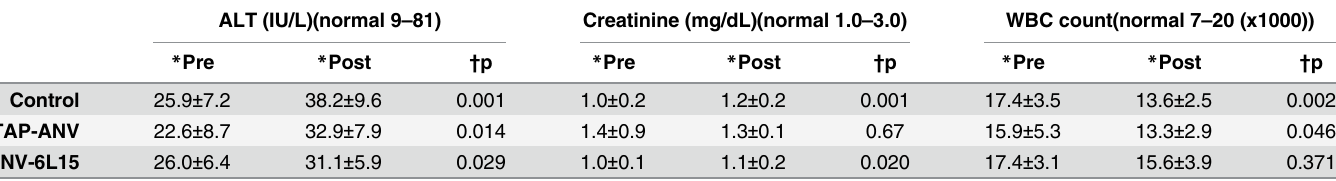
Table 2. Serum chemistries.